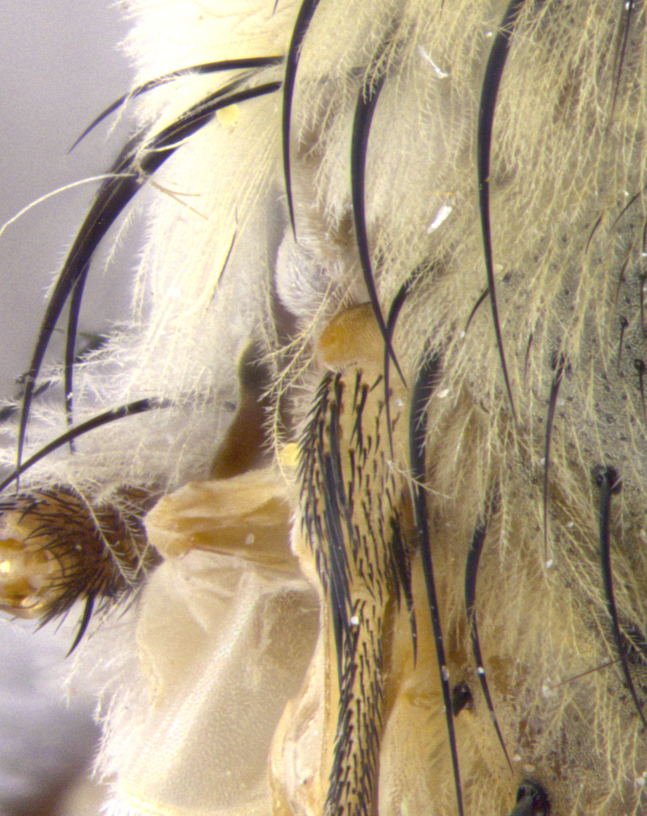
Telothyria
auranticrus
sp. n. displaying the beige color basicosta.